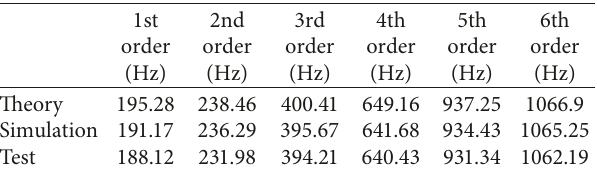
Figure 7: Comparison of simulation and experiment results: first-order natural frequency simulation (a) and laboratory test (b); second- order natural frequency simulation (c) and laboratory test (d); third-order natural frequency simulation (e) and laboratory test (f); fourth- order natural frequency simulation (g) and laboratory test (h); fifth-order natural frequency simulation (i) and laboratory test (j); 12th order natural frequency simulation (k) and laboratory test (l). Table 1: Comparison of theoretical, simulation, and experimental results.